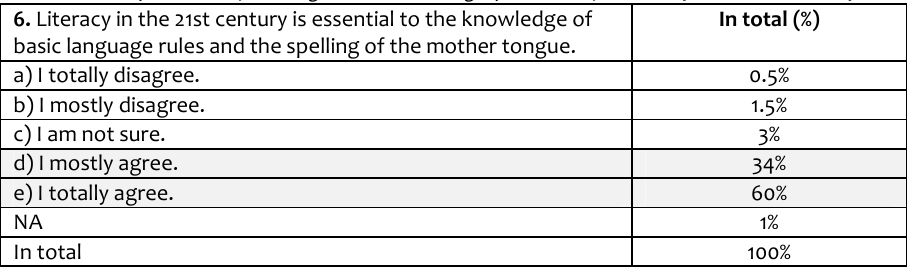
Table 7. The importance of the linguistic and orthographic norm for literacy in the 21 st century 6. Literacy in the 21st century is essential to the knowledge of basic language rules and the spelling of the mother tongue.